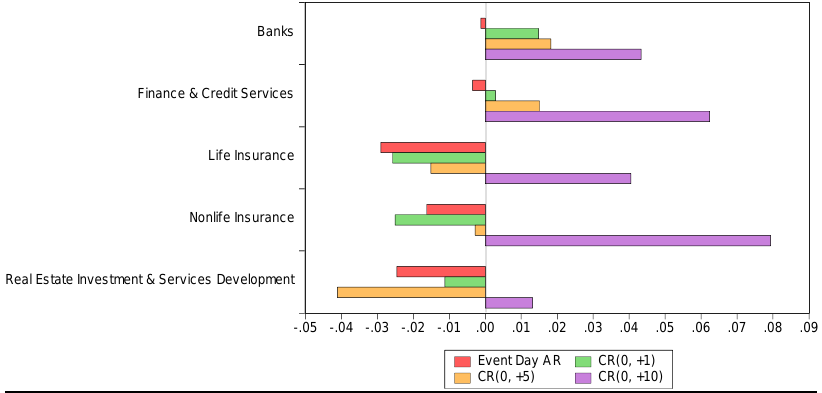
Figure 1: ARs and CRs of U.S. financial sectors in response to the September 11 th